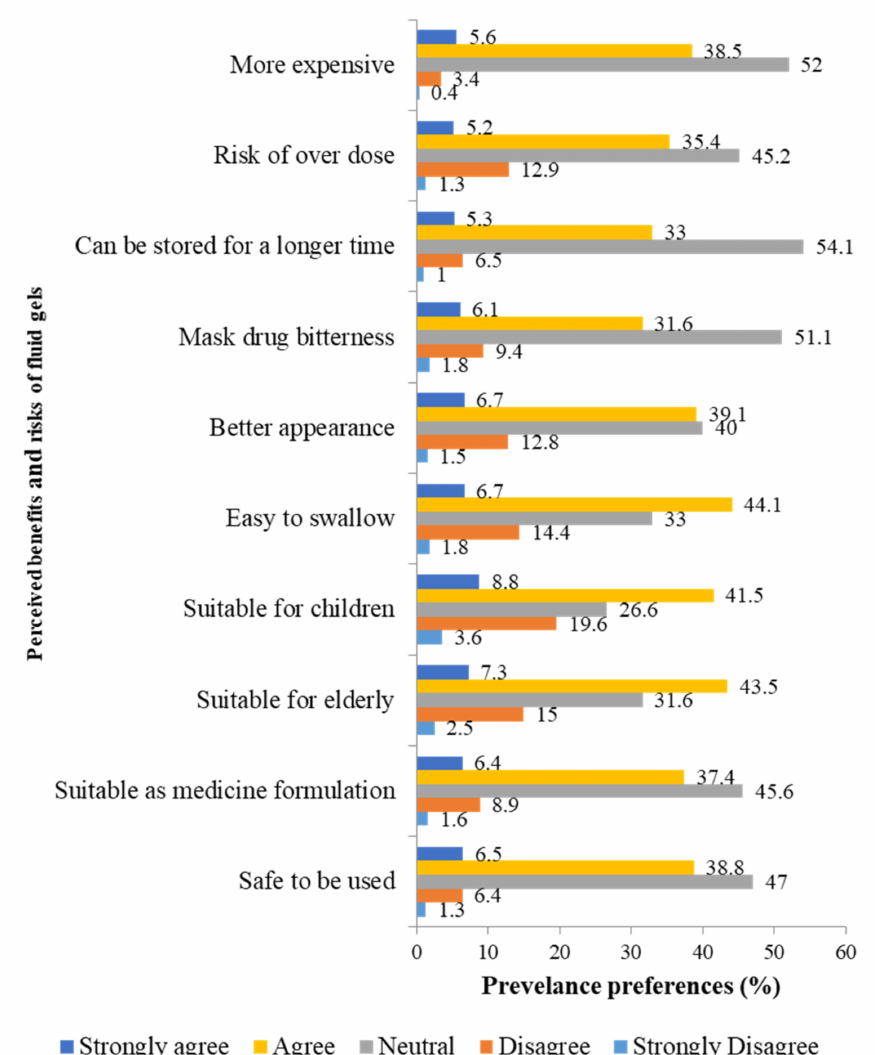
Figure 2. Perceived benefits and risks of fluid gels, Section 4 (n =